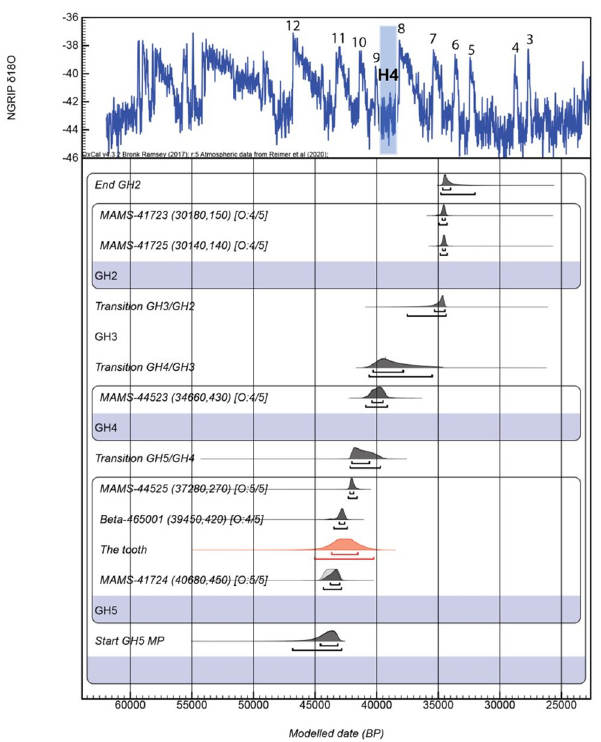
Fig 8. Bayesian model of Bawa Yawan rockshelter. Radiocarbon dates are calibrated using IntCal20 [43]; the model and boundaries were calculated using OxCal 4.3, including a General t-type Outlier Model [49]. Outliers prior and posterior probability are shown in square brackets. The chronology is compared to the North Greenland Ice Core Project (NGRIP) Greenland Ice Core Chronology 2005 (GICC05) δ 18 O palaeo-environmental record [50] with warm Dansgaard-Oeschger events (from 12 to 3) and Heinrich stadial